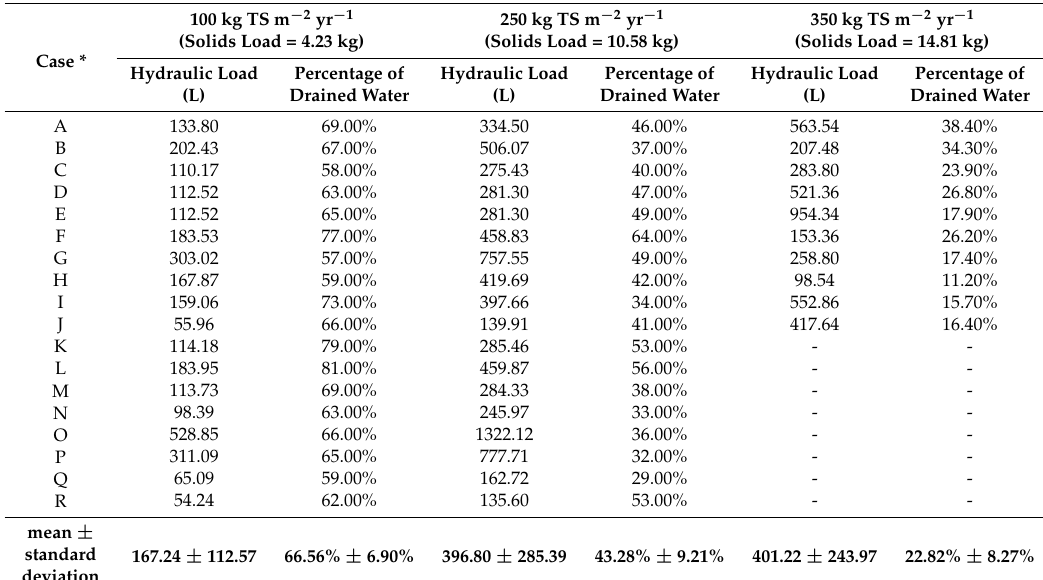
Table 2. Dewatering efficiency in Phase I of the